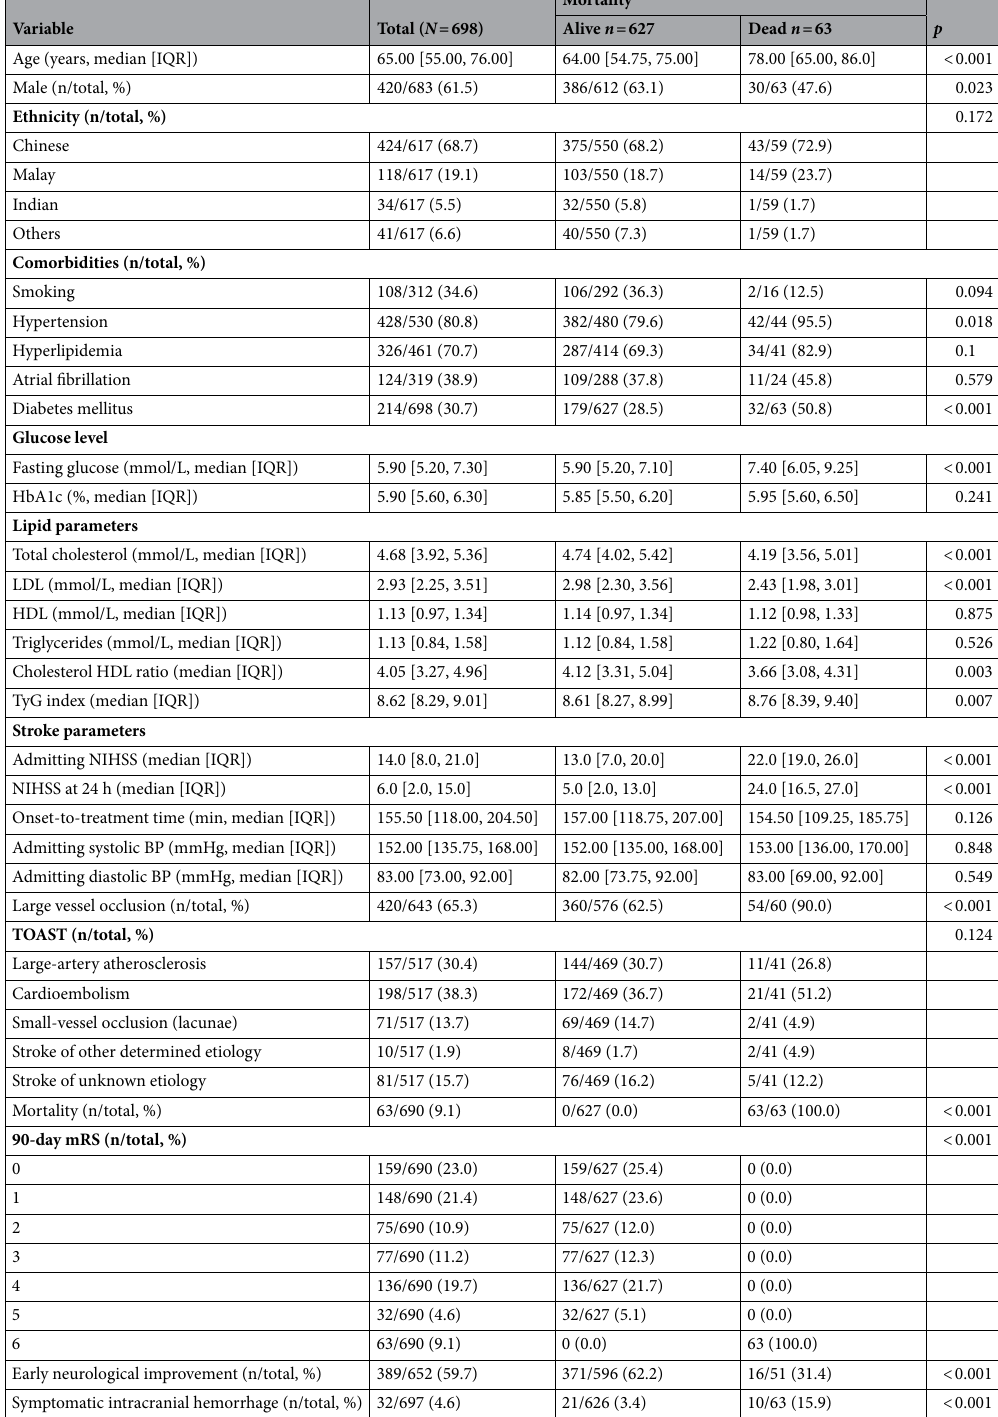
Table 1. Characteristics of all patients that underwent IV-tPA, and comparison between patients stratified by mortality. n number, total number of non-missing values of each variable, p p-value of Pearson’s Chi-squared test for categorical variables and Mann–Whitney U test for continuous variables, IQR interquartile range, mmol/L millimoles per liter, min minutes, mmHg millimeters of mercury, LDL low density lipoprotein, HDL high density lipoprotein, TyG index triglyceride-glucose index, NIHSS National Institutes of Health Stroke Scale, OTT onset-to-treatment time, BP blood pressure, TOAST trial of org 10172 in acute stroke treatment, mRS modified Rankin